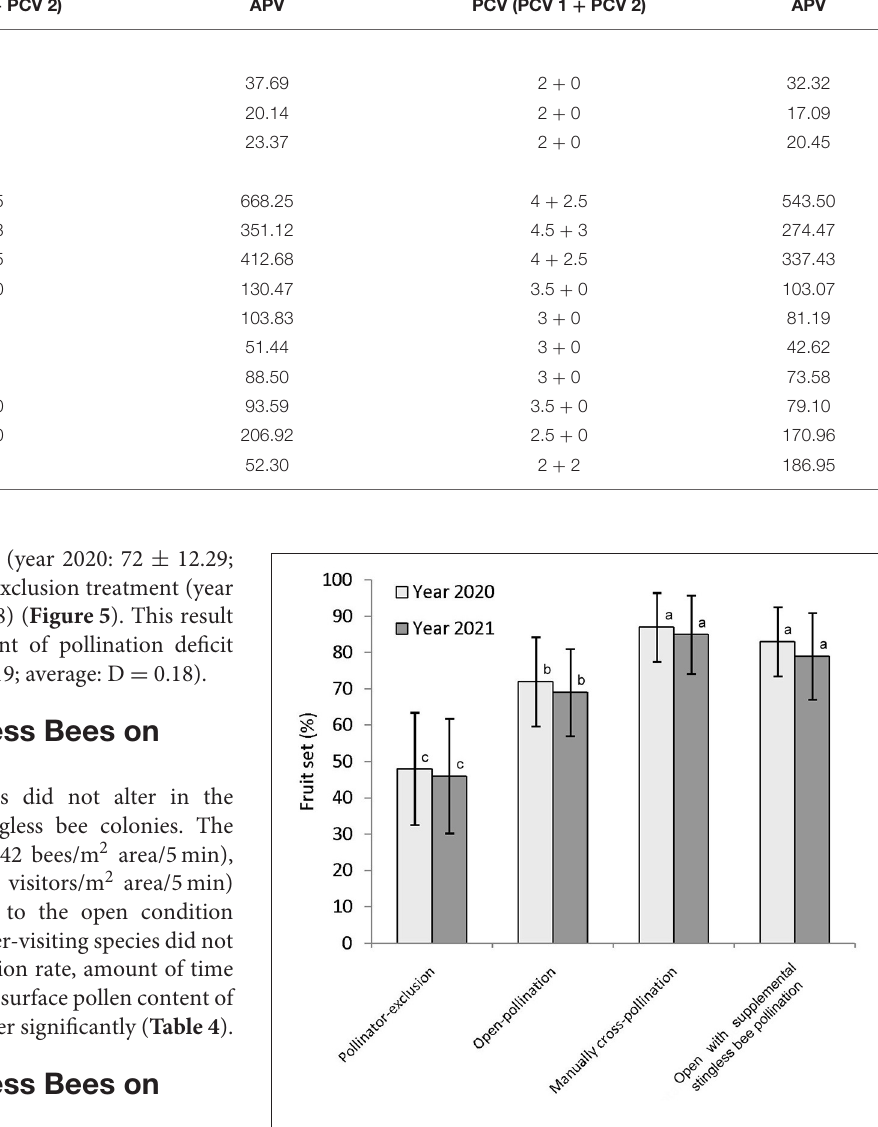
FIGURE 5 | Fruit set of fennel in different pollination treatments. Values are given by mean ± standard deviation. Different letters indicate significant differences by Tukey-b post-hoc test ( p <